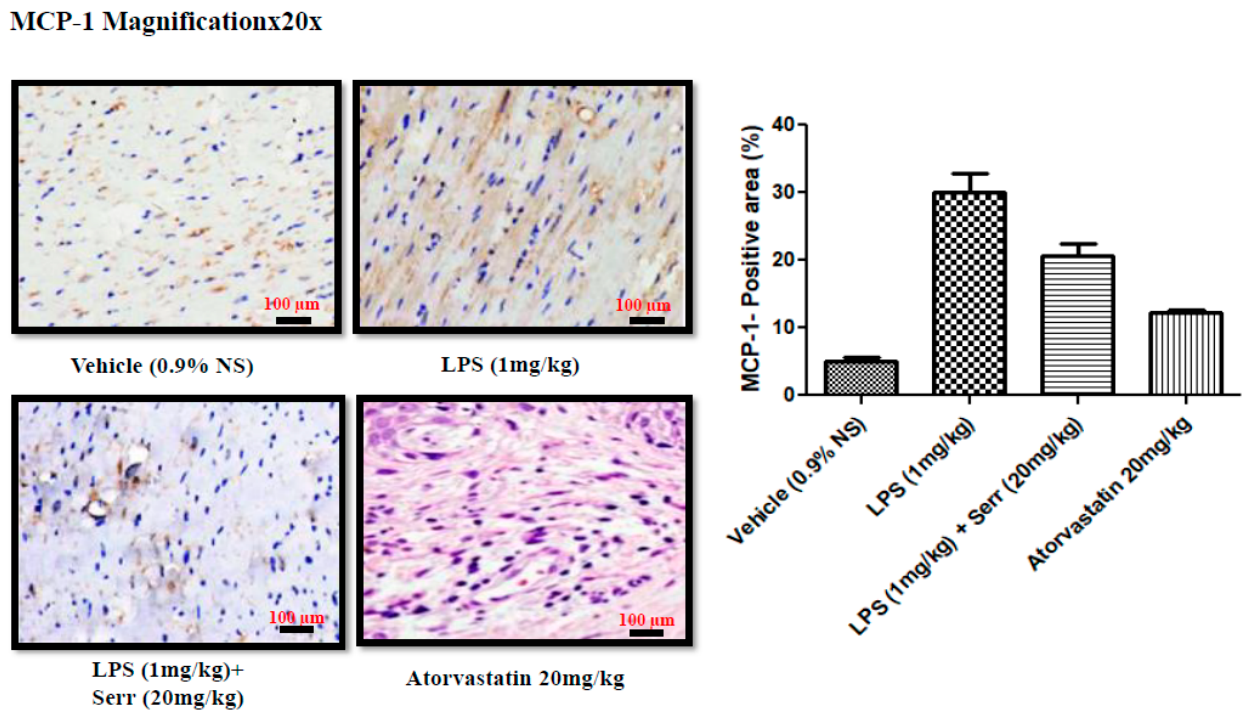
Figure 4. Immunohistochemistry analysis. MCP-1 expression of the heart ventricular sections from each mouse (20 × , scale bar: 50 µ m; n = 6 per group, at least 10 randomly selected heart sections per mouse). Data are presented as mean standard deviation. One-way ANOVA was applied.